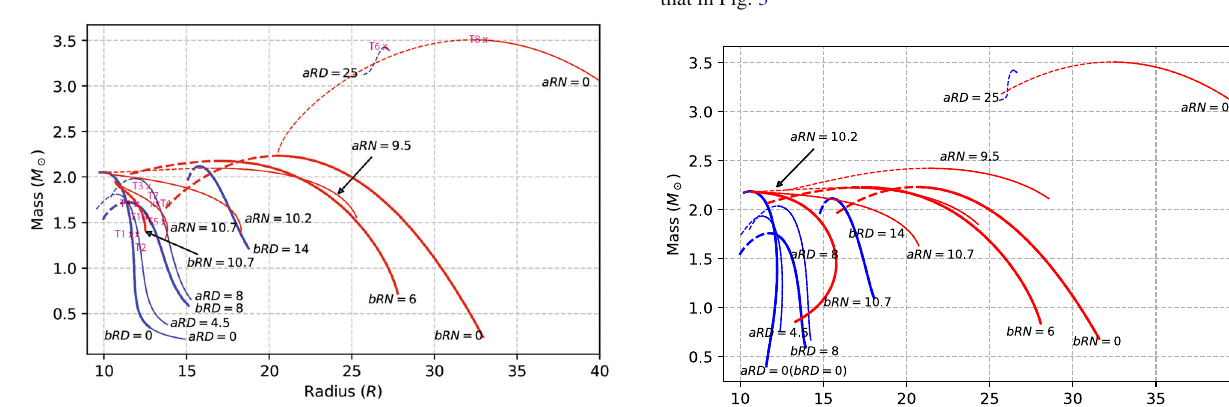
by dash line in Figs. 3, 4 and 5), this may imply some first order phase transition. On the other hand, above this